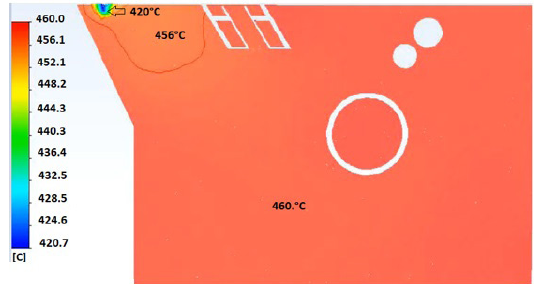
Figure 12. Temperature distribution after melting of the 25% ingot inserted into the zinc bath after 7.2